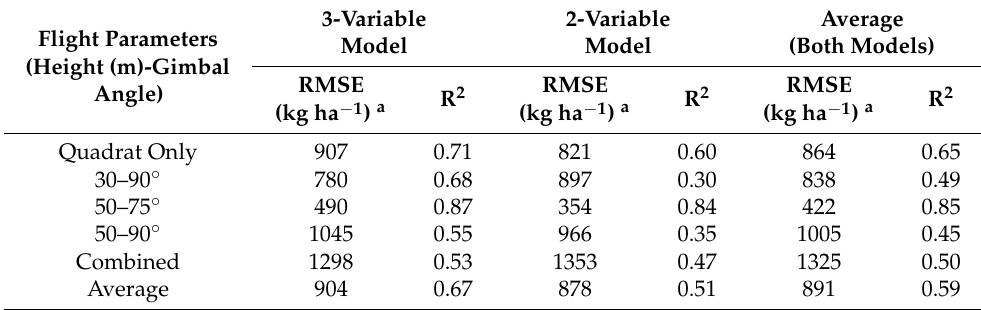
Table 7. Yield estimation accuracy using the 3D canopy models from different flight